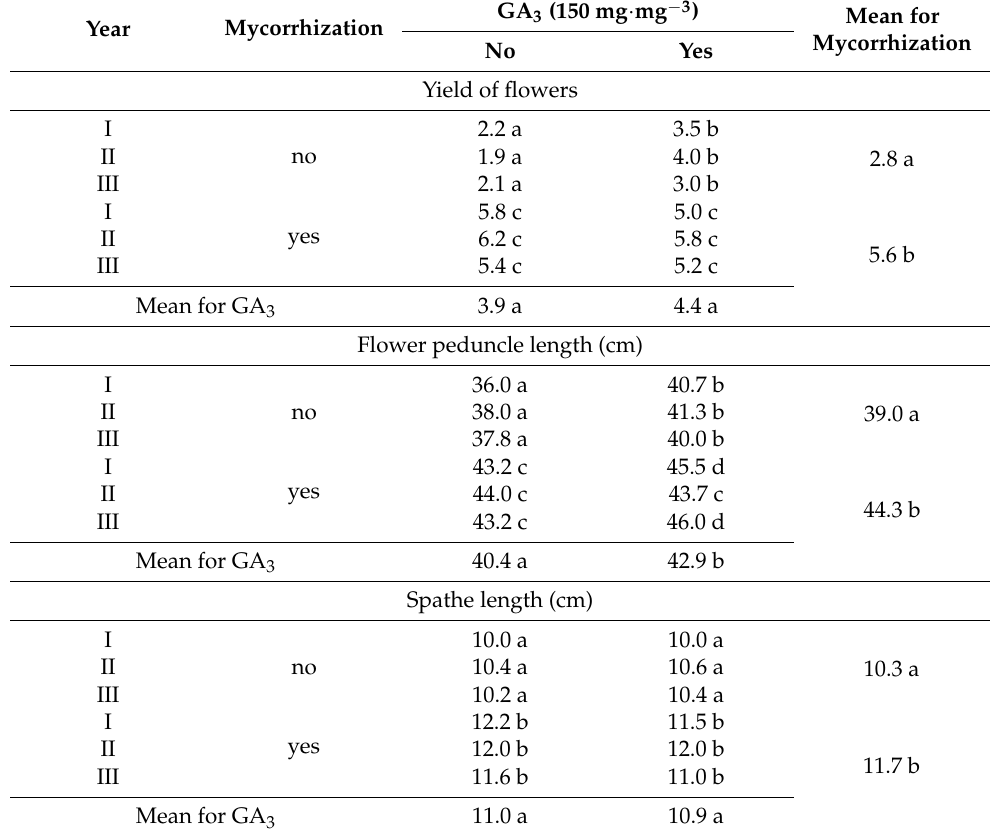
Table 1. The yield and quality of the inflorescences of Zantedeschia albomaculata ‘Albomaculata’ plants after the treatment with AMF and GA 3 . The means followed by the same letter do not differ significantly at α =